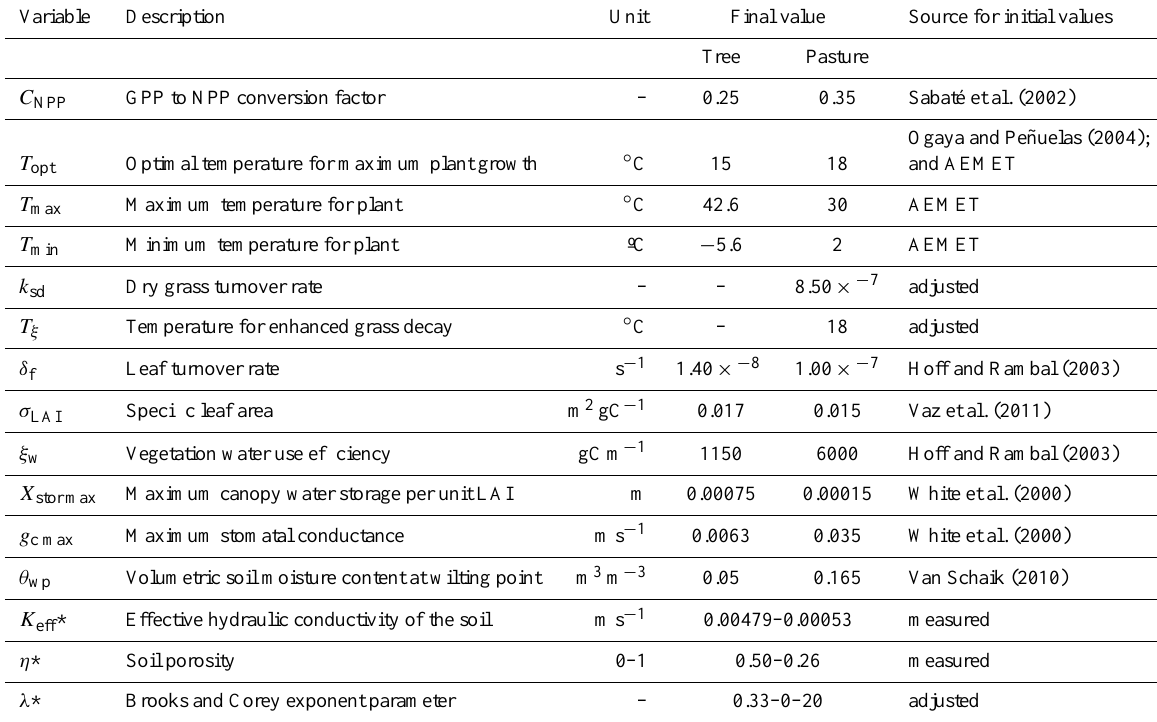
Table 2. Set of model parameters included in the process of manual calibration.